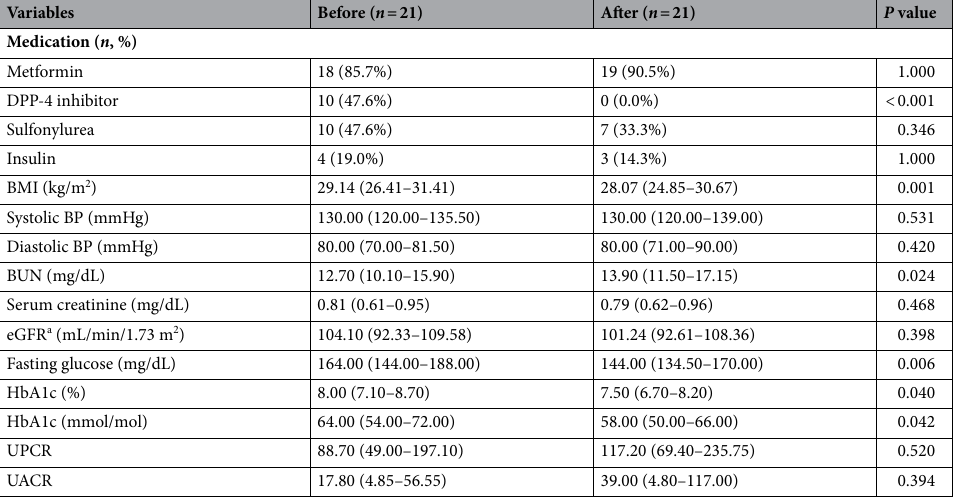
Table 2. Change in demographic and clinical parameters after SGLT2 inhibitor treatment. Values are expressed as n (%) for categorical data and median (interquartile range) for continuous data. BMI body mass index, BP blood pressure, BUN blood urea nitrogen, DPP-4 dipeptidyl peptidase-4, eGFR estimated glomerular filtration rate, HbA1c glycated hemoglobin, SGLT2 sodium-glucose co-transporter 2, UACR urinary albumin to creatinine ratio, UPCR urinary protein to creatinine ratio. a The eGFR was calculated using the chronic kidney disease epidemiology collaboration (CKD-EPI)